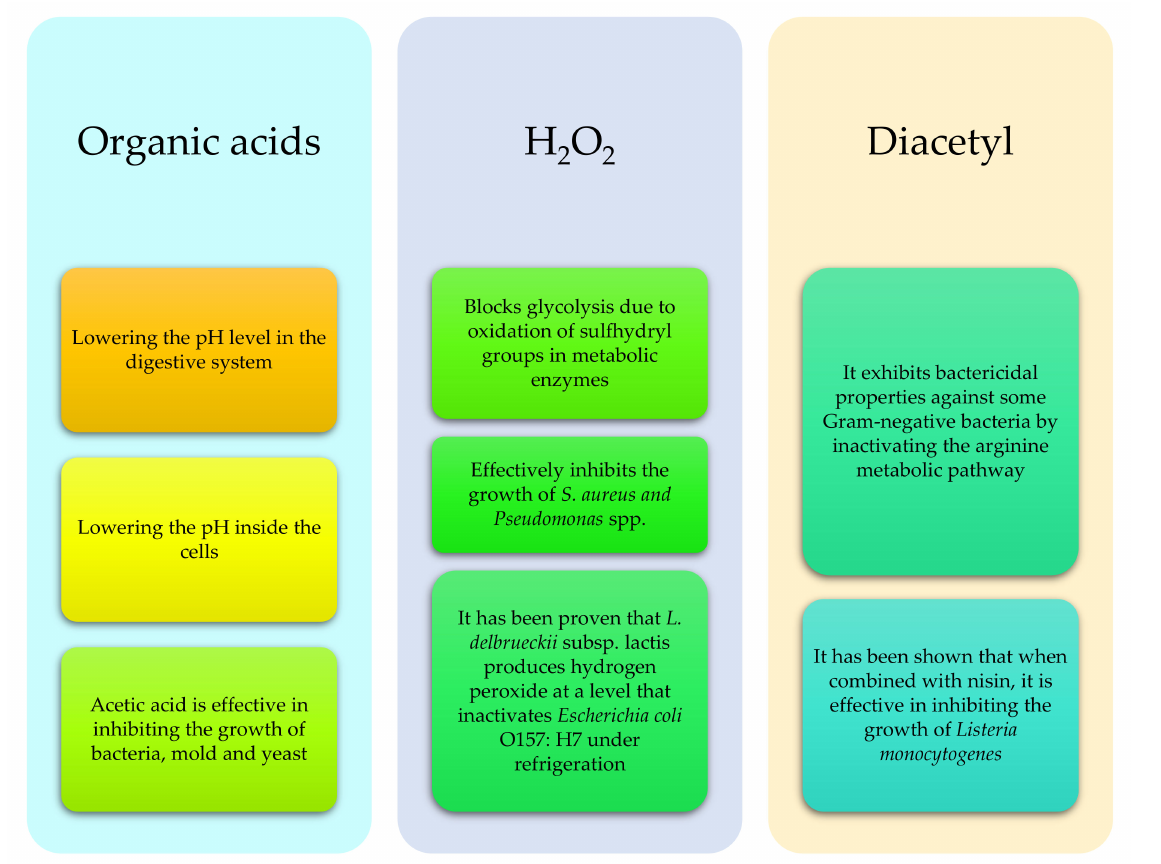
Figure 2. Selected antibacterial and bacteriostatic substances produced by probiotic microorganisms and their action in the digestive system of ruminants (based on: